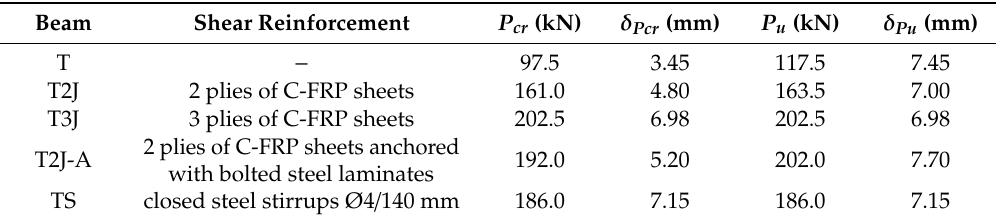
Table 1. Test results.